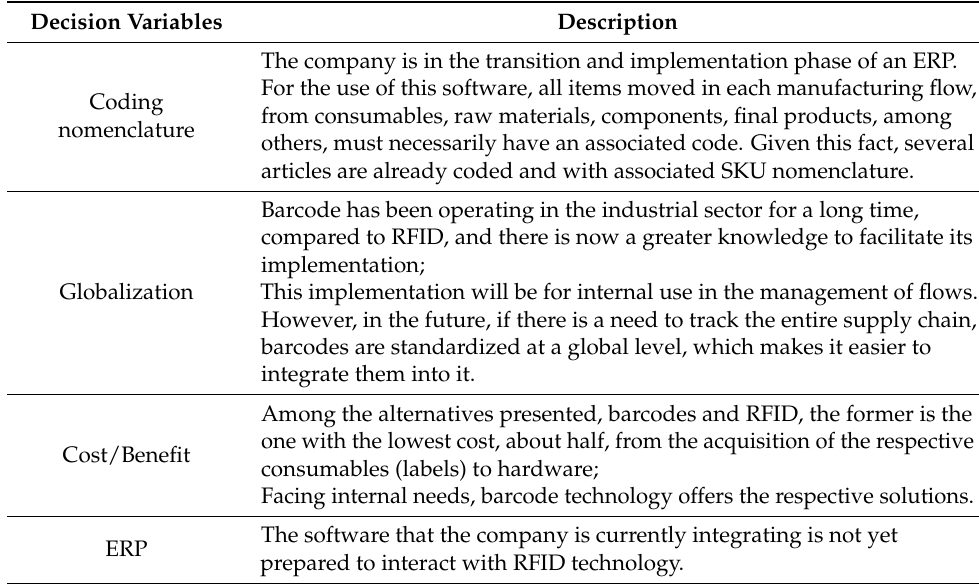
Table 6. Variables for deciding which technology to